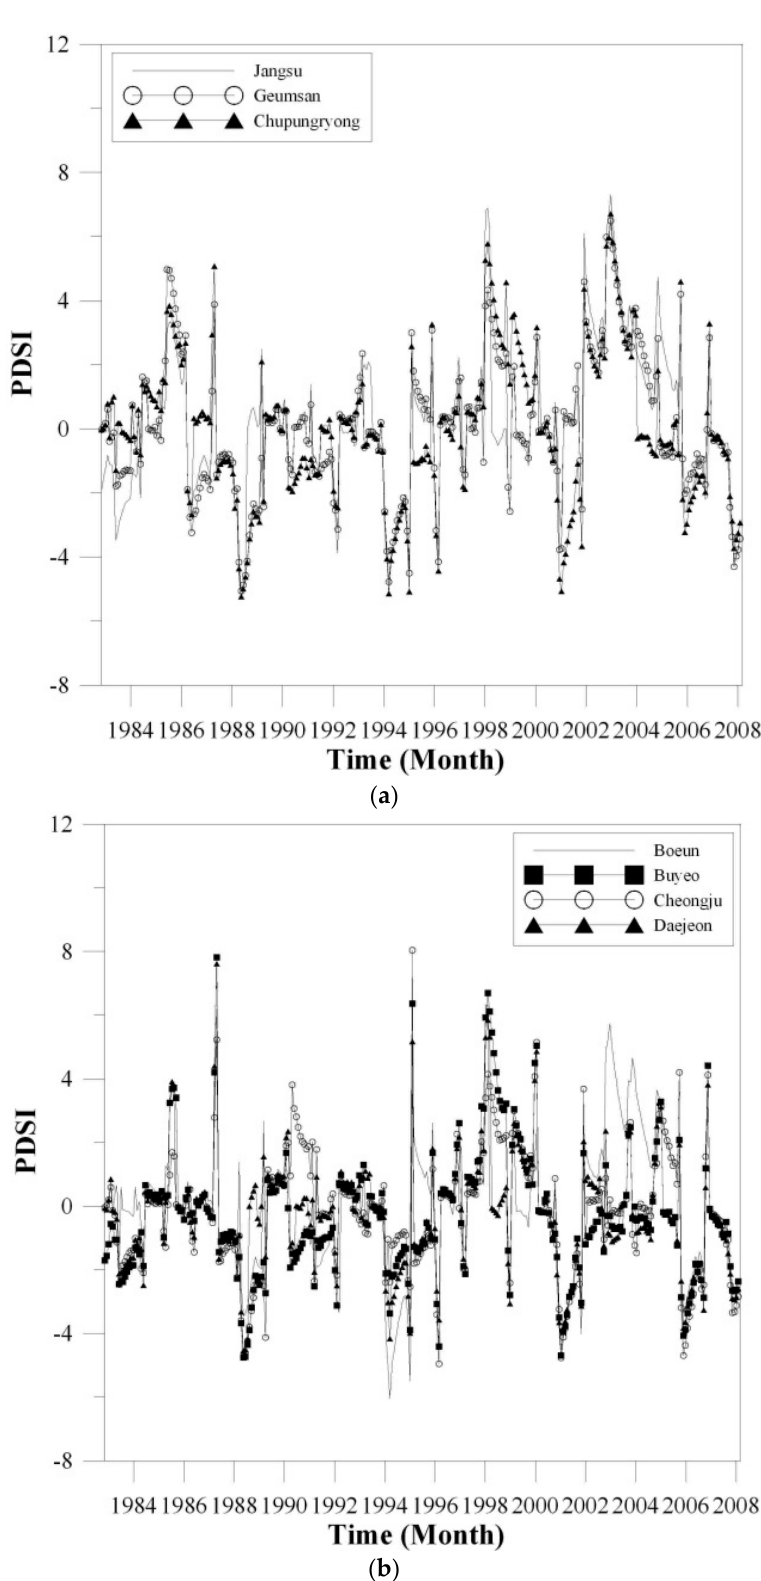
Figure 8. Results of PDSI calculated for the Geum River Basin: ( a ) Jangsu, Geumsan, and Chupungryong; and ( b ) Boeun, Cheongju, Daejeon, and Buyeo.